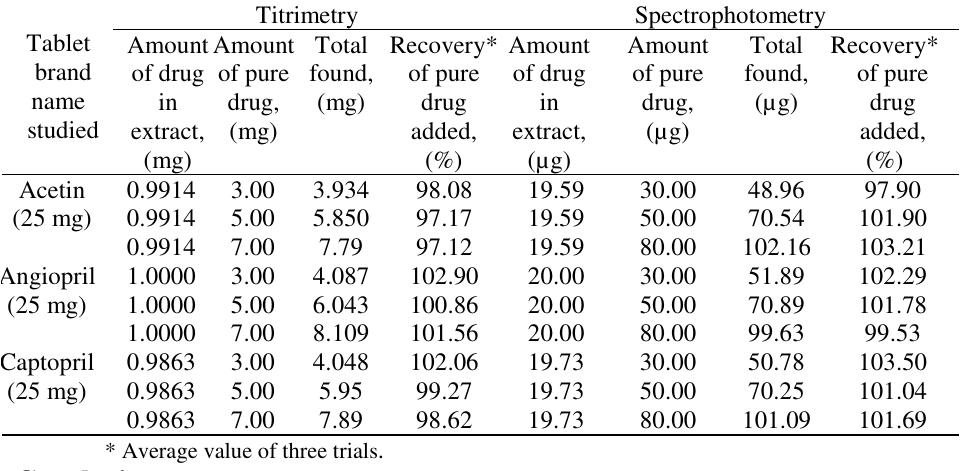
Table 3. Results of recovery study using standard-addition